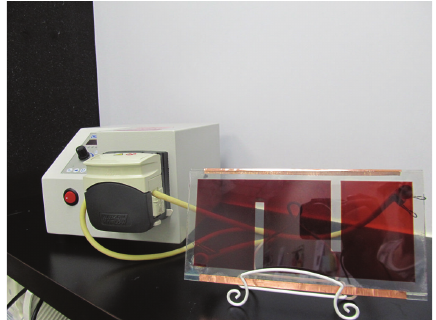
Figure 6: The photo of the prototype reusable DSC